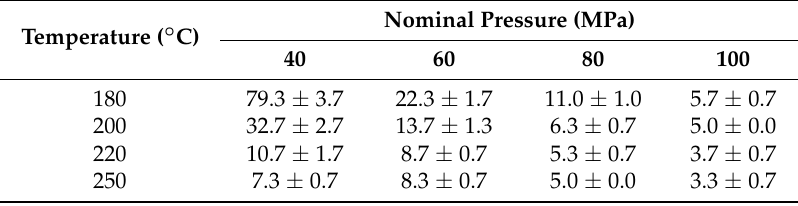
Table 4. Anti-scuffing time duration of the NCM/Fe pair.*